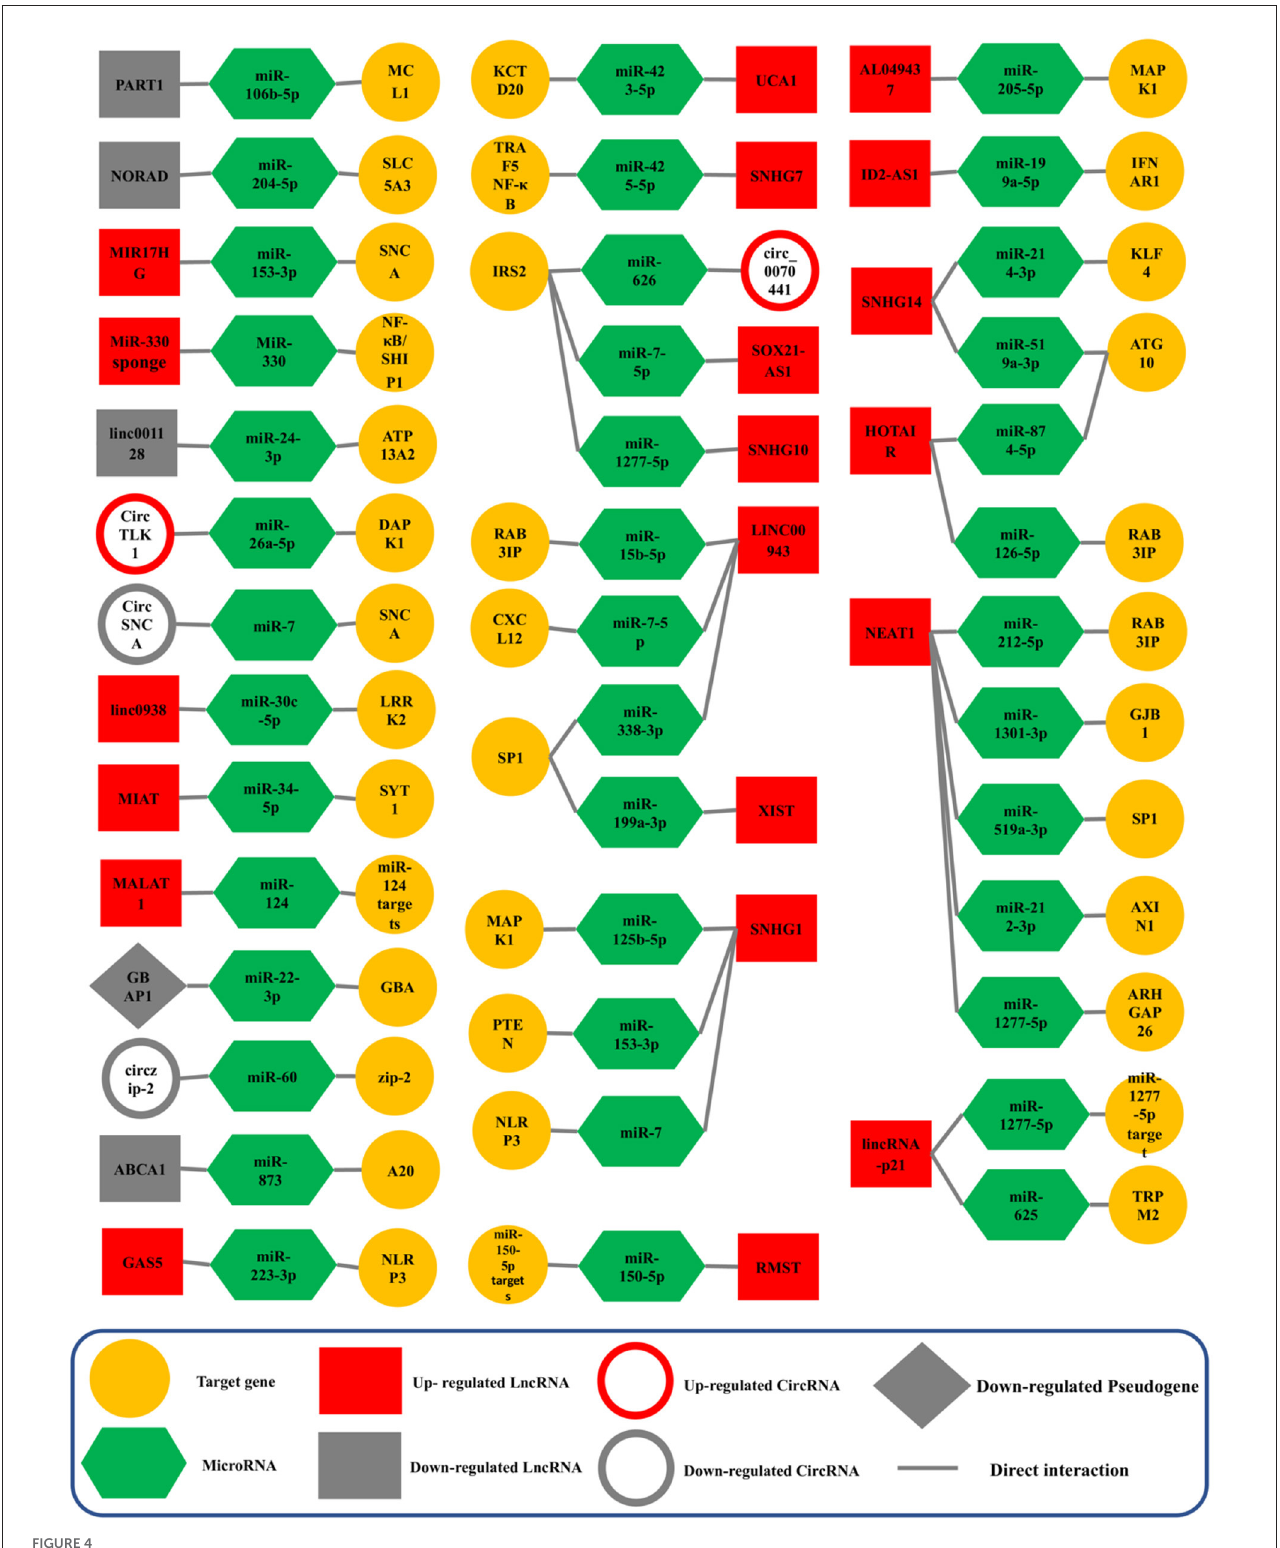
FIGURE4 Validated ceRNA axes in PD. The red and gray colors of the squares indicate an increase and a decrease in the expression of lncRNAs, circRNAs, and pseudogenes, respectively. This schematic figure shows the importance of the constituent components of ceRNA axes. In addition, this figure shows that the studies around which of these components have been more extensive. NEAT1, the SNHG family, and LINC00943 were among the lncRNAs studied most on these axes. CircRNA, circular RNA; lncRNA, long non-coding RNA; miRNA,